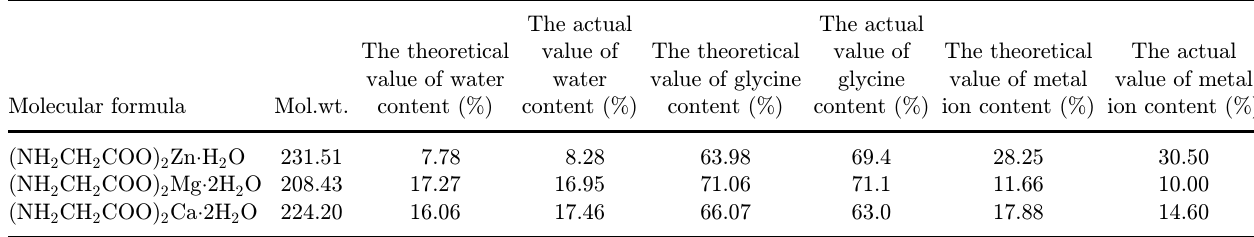
Table 6. Summary of the comprehensive analysis